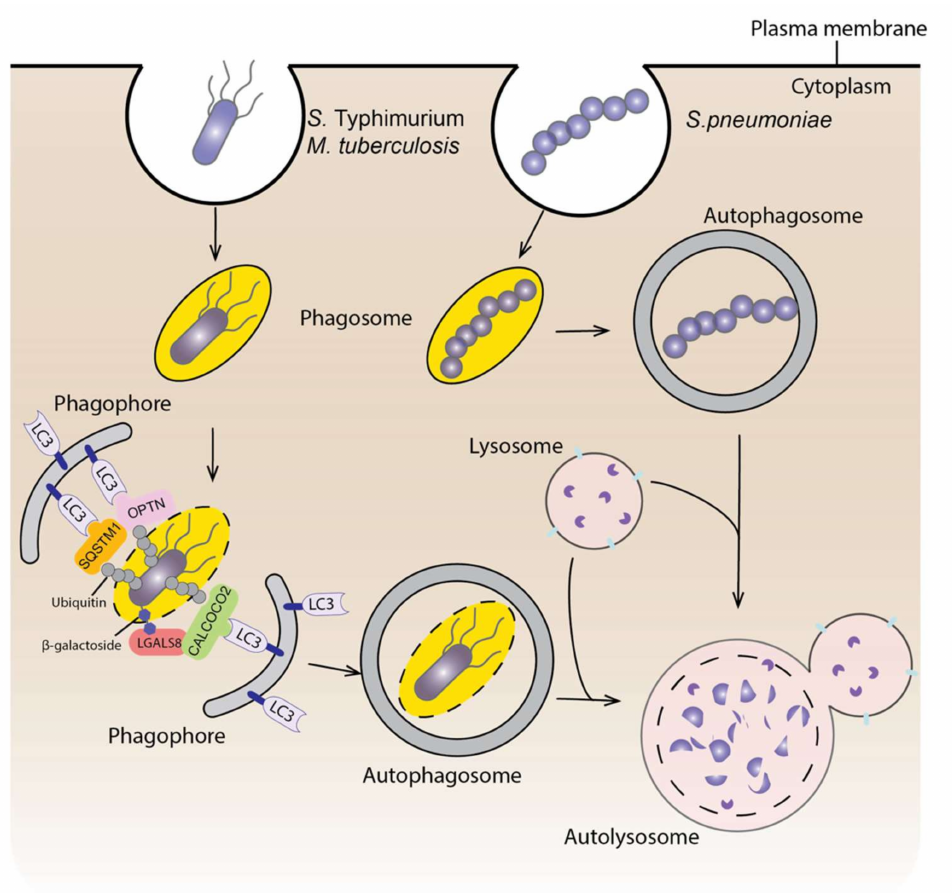
Figure 3. Autophagy and bacterial infection. Bacteria enter the cell within a phagosome or vac- uole. Autophagy can target the bacteria within a damaged vacuole or phagosome (such as S. Typhimurium and M. tuberculosis ). The ubiquitination of the bacterium and the recognition of β - galactoside by LGALS8 will recruit autophagy receptors to target the bacterium in to the phagophore. Autophagy can also target cytosolic bacteria (such as S. pneumoniae ) causing them to be trapped within an autophagosome. Subsequently, the autophagosome will fuse with a lysosome to degrade invading